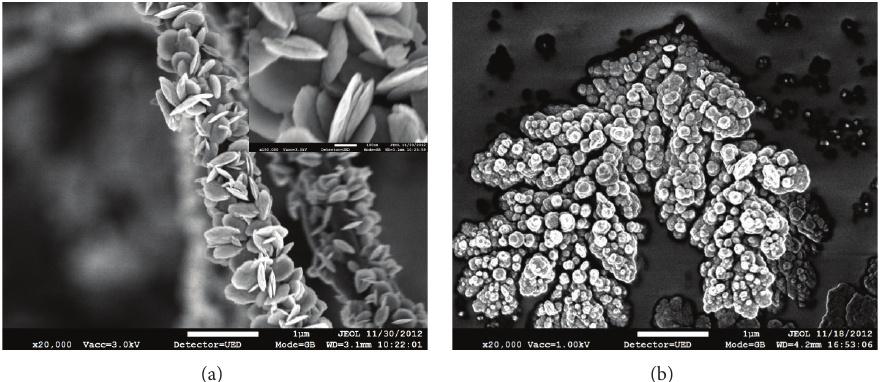
Figure 6: SEM images of (a) as-obtained Fe 2 O 3 -CNFs (inset is the high magnification of (a)) and (b) Fe 2 O 3 without CNFs.